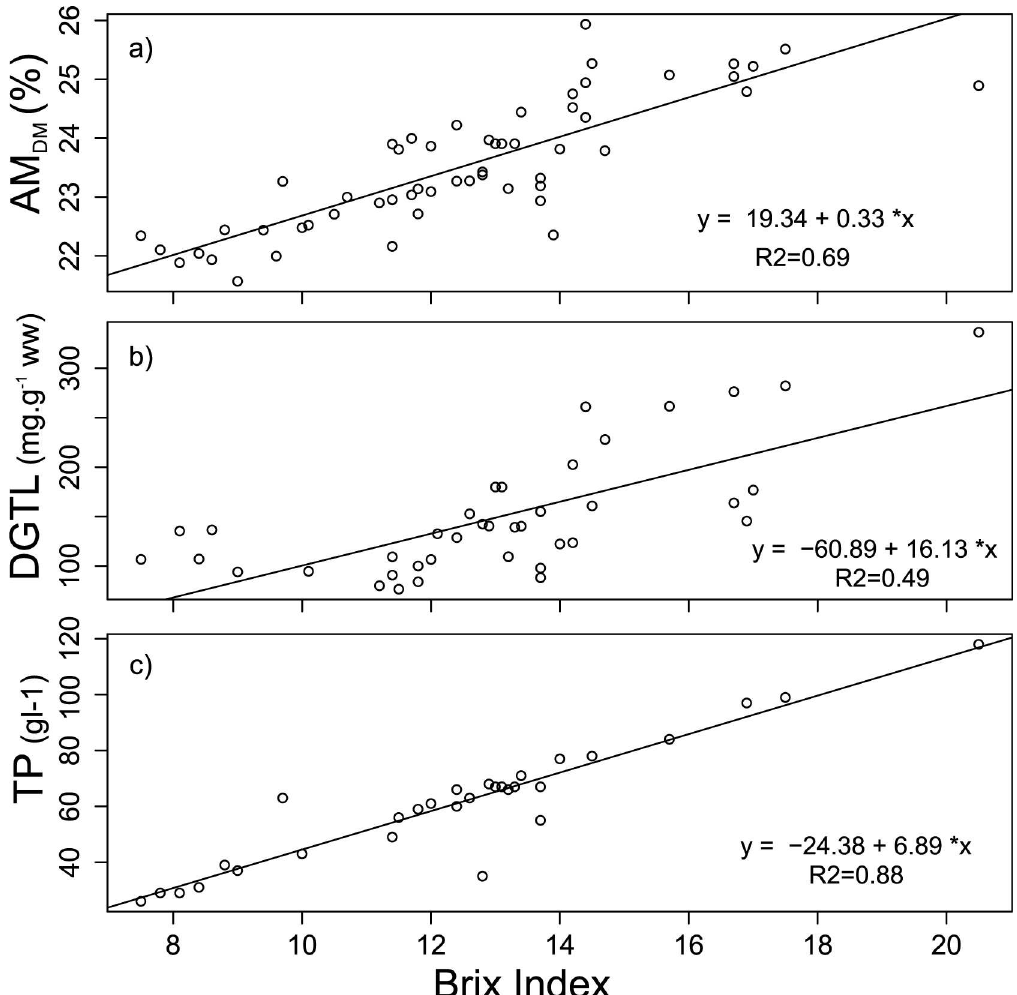
Fig 2. Relationship between Brix index and a) AM DM (abdominal muscle dry matter content), b) HP TL (hepatopancreas total lipid in wet weight), and c) TP (total haemolymph protein). Regression lines and corresponding equationsare